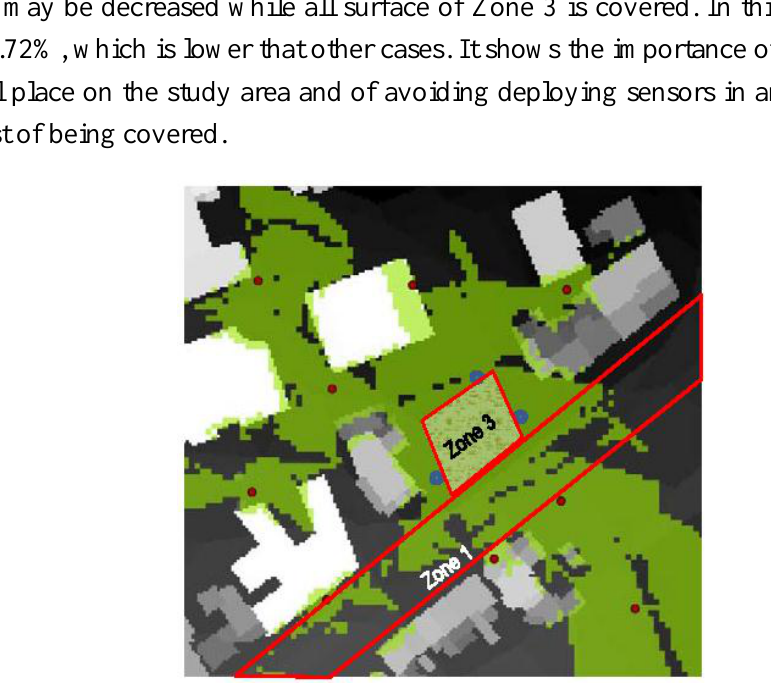
Figure 24. Coverage map of deploying 12 sensors using the context-aware method, considering the activity in the network; Zone 3: the area with low activity, but high interested to be